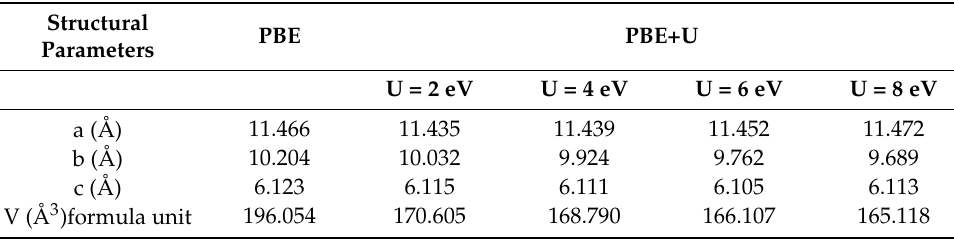
Table 1. Optimized lattice parameters and unit cell volume of monoclinic CuPPD estimated with PBE and PBE+U for AFM configuration.